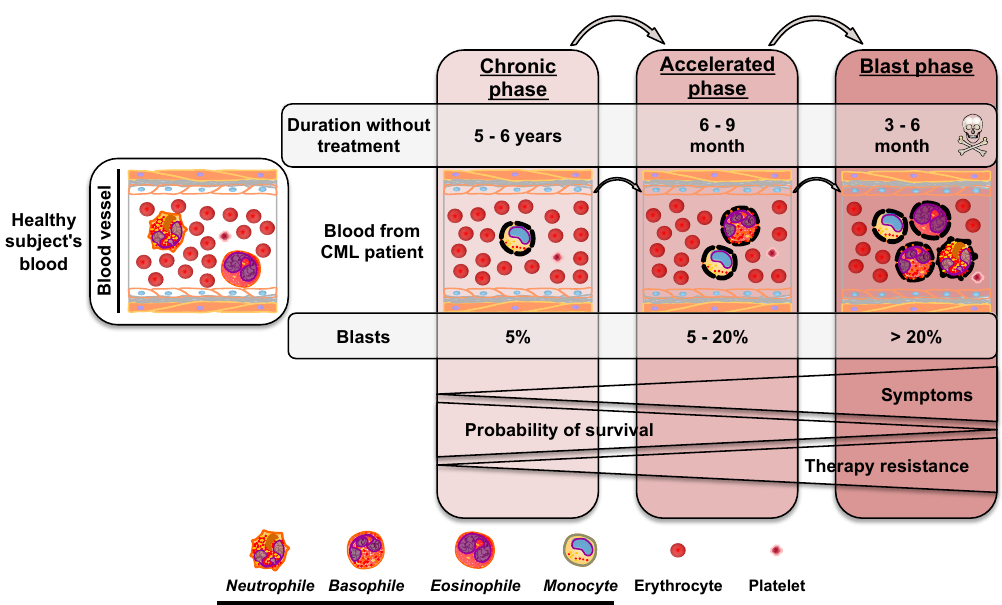
Figure 1. Progression of chronic myeloid leukemia. Chronic myeloid leukemia (CML) is characterized by an excessive proliferation of non-functional leukocytes (dotted lines) or blasts in the bone marrow and then in the blood. The chronic phase remains generally asymptomatic, during which 5% blasts are found in the bloodstream. After 5 to 6 years without treatment, the pathology progresses towards the accelerated phase (5% to 20% blasts) and symptoms including fatigue and loss of appetite and weight begin to appear. Without treatment, the accelerated phase progresses in 6 to 9 months to the blast phase (more than 20% blasts), causing rapid deterioration of the general condition of the patient and death after only a few months without management. Symptoms and resistance to therapy increase during the course of chronic myeloid leukemia, while the probability of survival decreases.